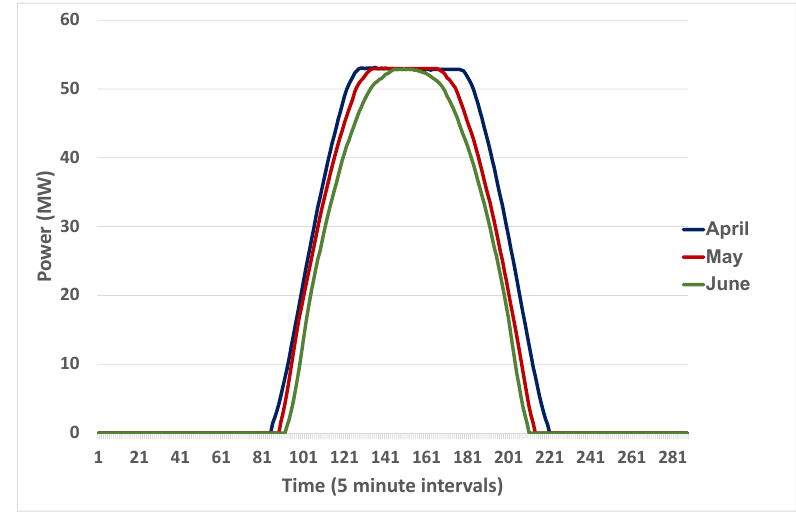
Figure 5. Solar farm